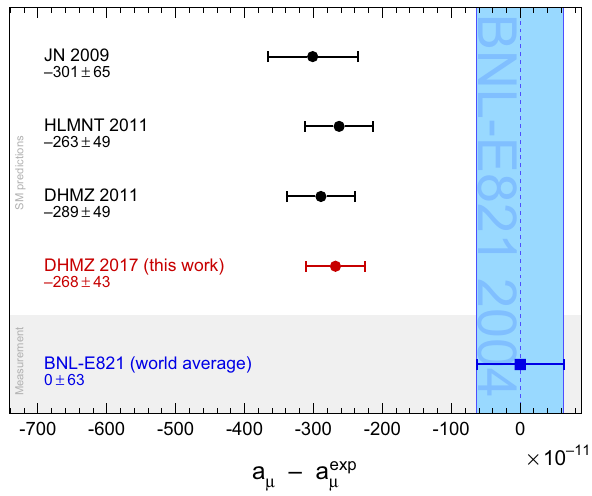
Fig. 11 Compilation of recent results for a SM μ (in units of 10 − 11 ), sub- tracted by the central value of the experimental average [64–66]. The shaded vertical band indicates the experimental uncertainty. The rep- resentative SM predictions are taken from this work (DHMZ 2017), DHMZ 2011 [2], HLMNT 2011 [67], and JN 2009